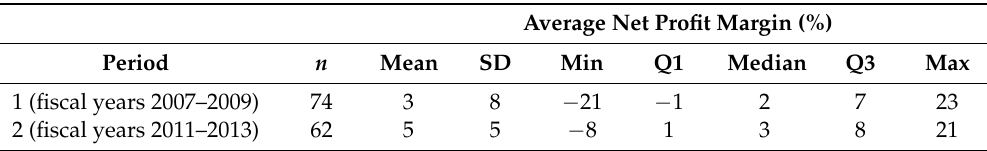
Table 6. Contractors’ profitability for each studied period.